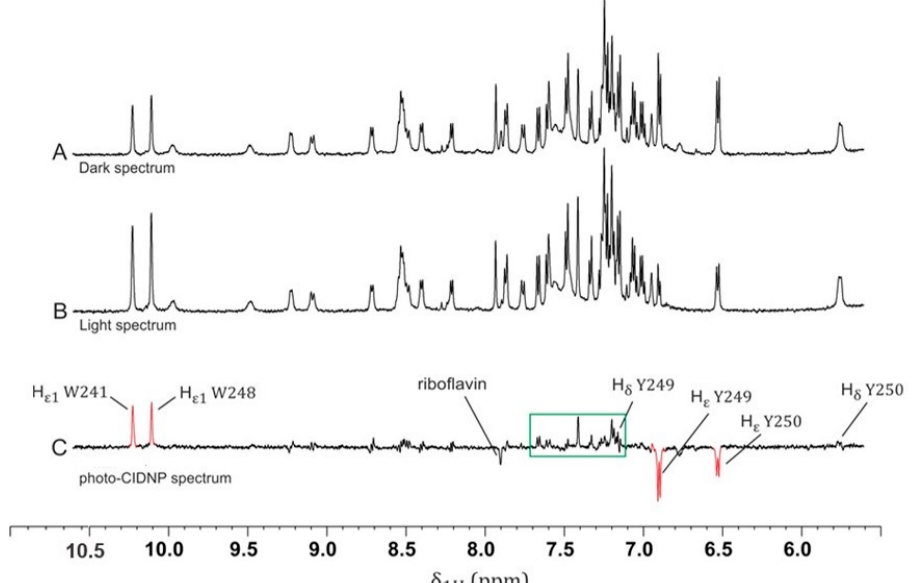
Figure 1. 1 H NMR spectra of 1 mM LytA 239–252 peptide in aqueous solution (H 2 O/D 2 O 9:1 v / v ): ( A ) dark spectrum; ( B ) light spectrum; ( C ) photo-CIDNP spectrum (B–A). Method A was followed for